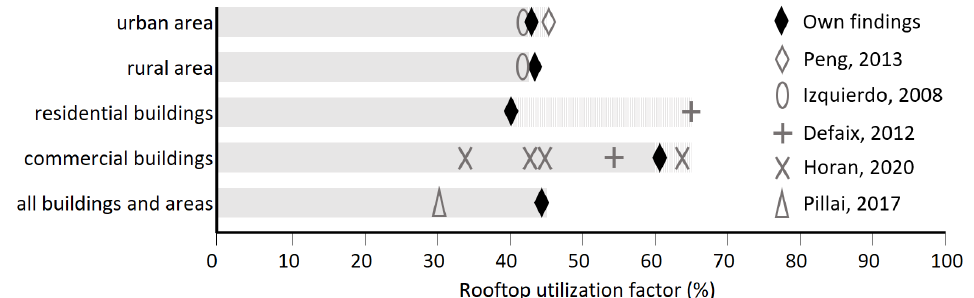
Figure 7. Comparison between rooftop utilization factors resulting from the proposed methodology and utilization factors found by other publications. Comparisons are made with regard to urban and rural areas and residential and commercial buildings. Publications used for comparison are as follows: Peng [45], Izquierdo et al. [13], Defaix et al. [14] Horan et al. [27] and Pillai and Banerjee